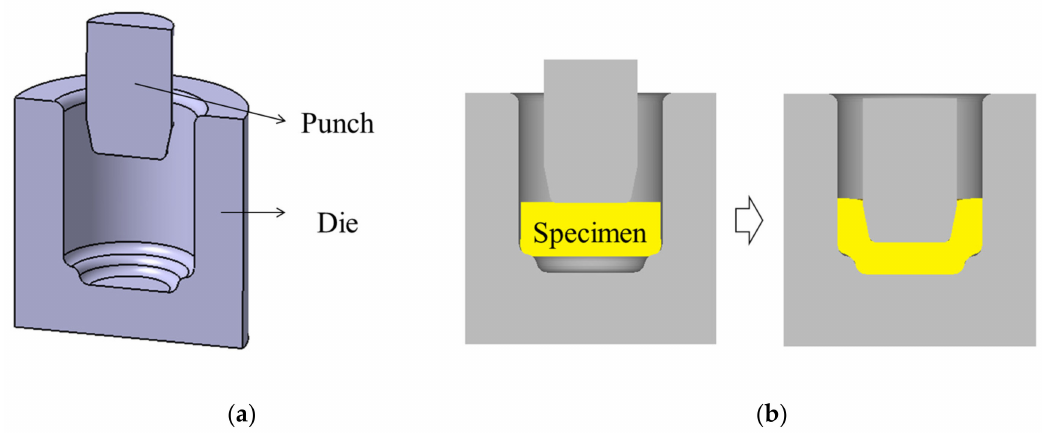
Figure 4. ( a ) Schematic of die and punch, and ( b ) arbitrary process for die stress analysis.